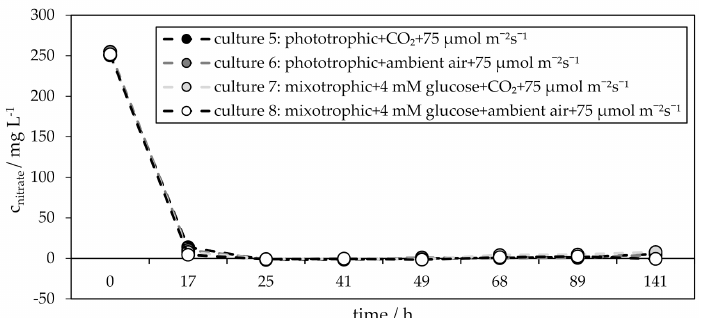
Figure 14. Time course of the nitrate concentration in the supernatant of the phototrophic cul- ture 5 (phototrophic + CO 2 + 75 µ mol m − 2 s − 1 ) and culture 6 (phototrophic + ambient air + 75 µ mol m − 2 s − 1 ), and mixotrophic culture 7 (mixotrophic + 4 mM glucose + CO 2 + 75 µ mol m − 2 s − 1 ) and culture 8 (mixotrophic + 4 mM glucose + ambient air + 75 µ mol m − 2 s − 1 ).